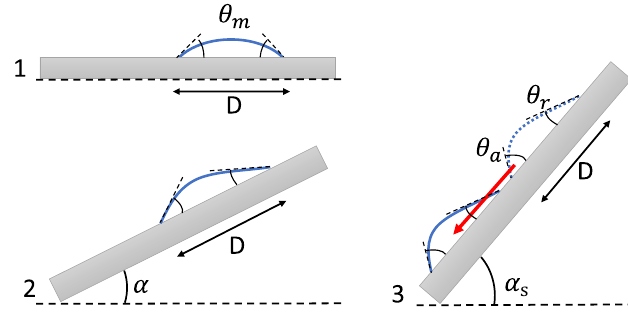
Fig. 3. Schematic representations of : (1) a drop of diameter D on a horizontal plane, (2) its deformation under gravity, when the plane which is progressively inclined and (3) the moment when the drop begins to slide. u a is the advancing angle and u r the